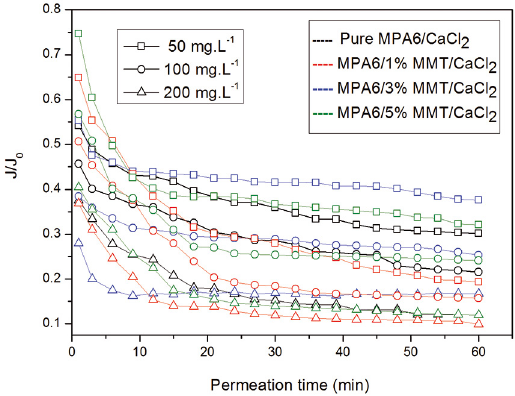
Figure 9. Influence of oil concentration (50, 100 and 200 mg.L -1 ) in the J/J for pure PA6 membranes and their hybrids with 1, 3, 5% 0 of MMT, at 1.0 bar of pressure.